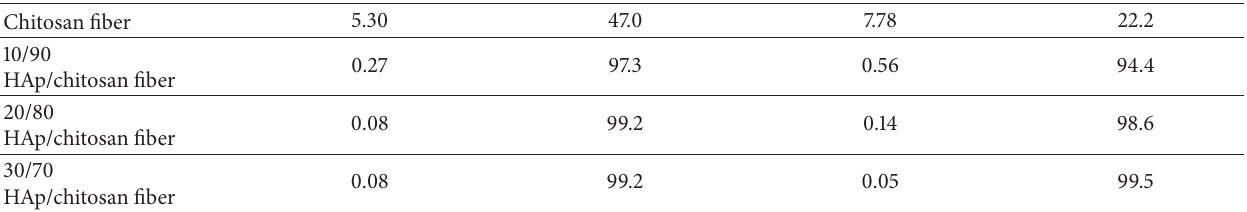
Table 1: Removal efficiency of Pb 2+ and Cd 2+ for the HAp/chitosan hybrid fibers with different HAp contents. For comparison, the removal efficiency for the chitosan fiber is also presented. The initial concentration of Pb 2+ and Cd 2+ was 10mg/L for all tests. Pb 2+ Cd